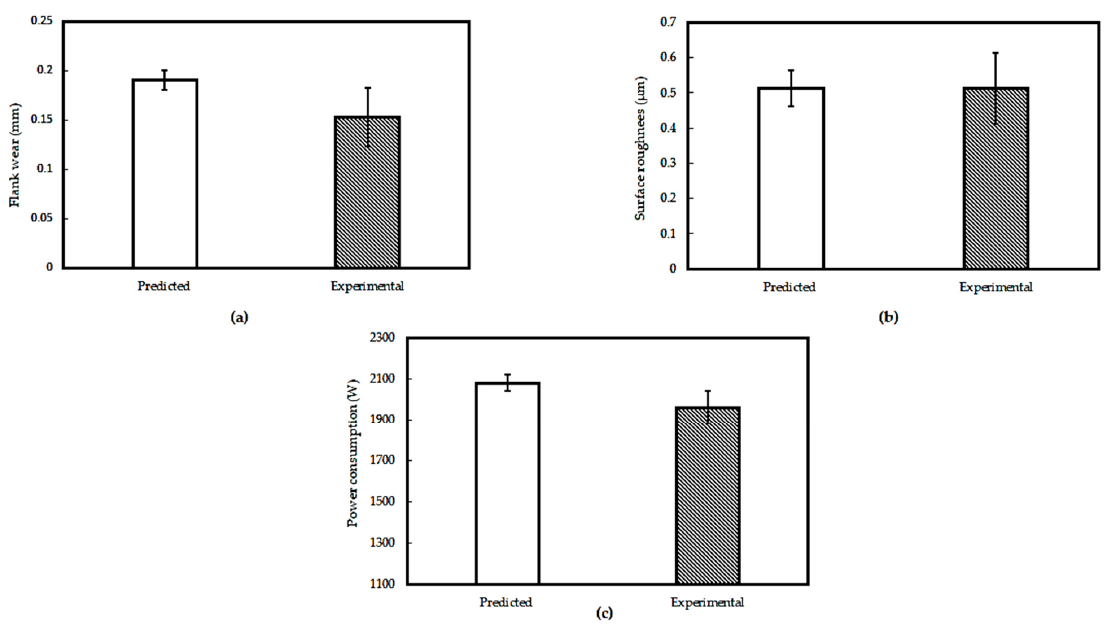
Figure 7. A comparison between the predicted and experimental results: ( a ) flank wear; ( b ) surface roughness; and ( c ) power consumption .